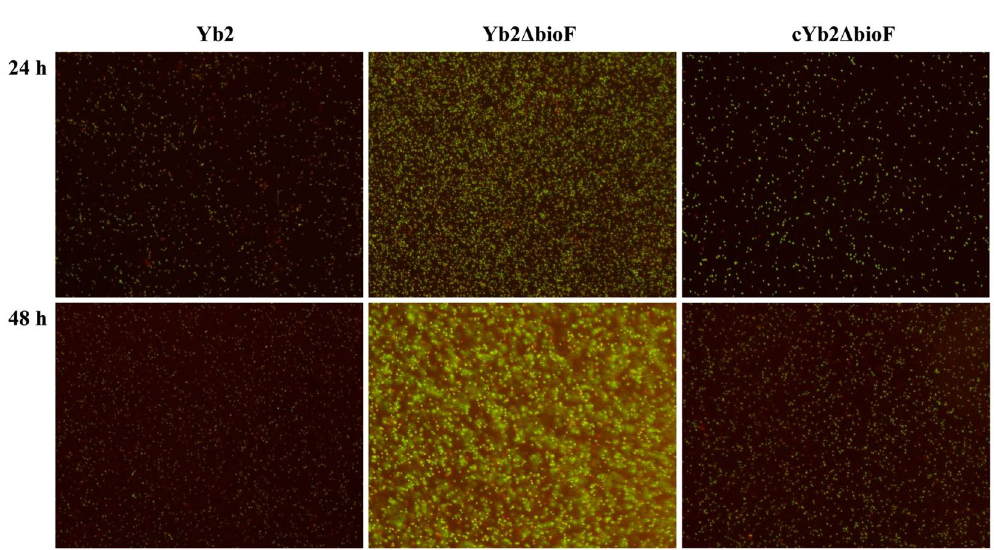
Figure 3. Observation of the biofilm formation. The biofilm formation of the wild-type strain Yb2, mutant strain Yb2 Δ bioF and complemented strain cYb2 Δ bioF was determined using an Live/dead BacLight Bacterial Viability staining and observed under fluorescence microscope at a 200 × magnification, which revealed that the mutant strain Yb2 Δ bioF had a stronger ability to form biofilm than the wild-type strain